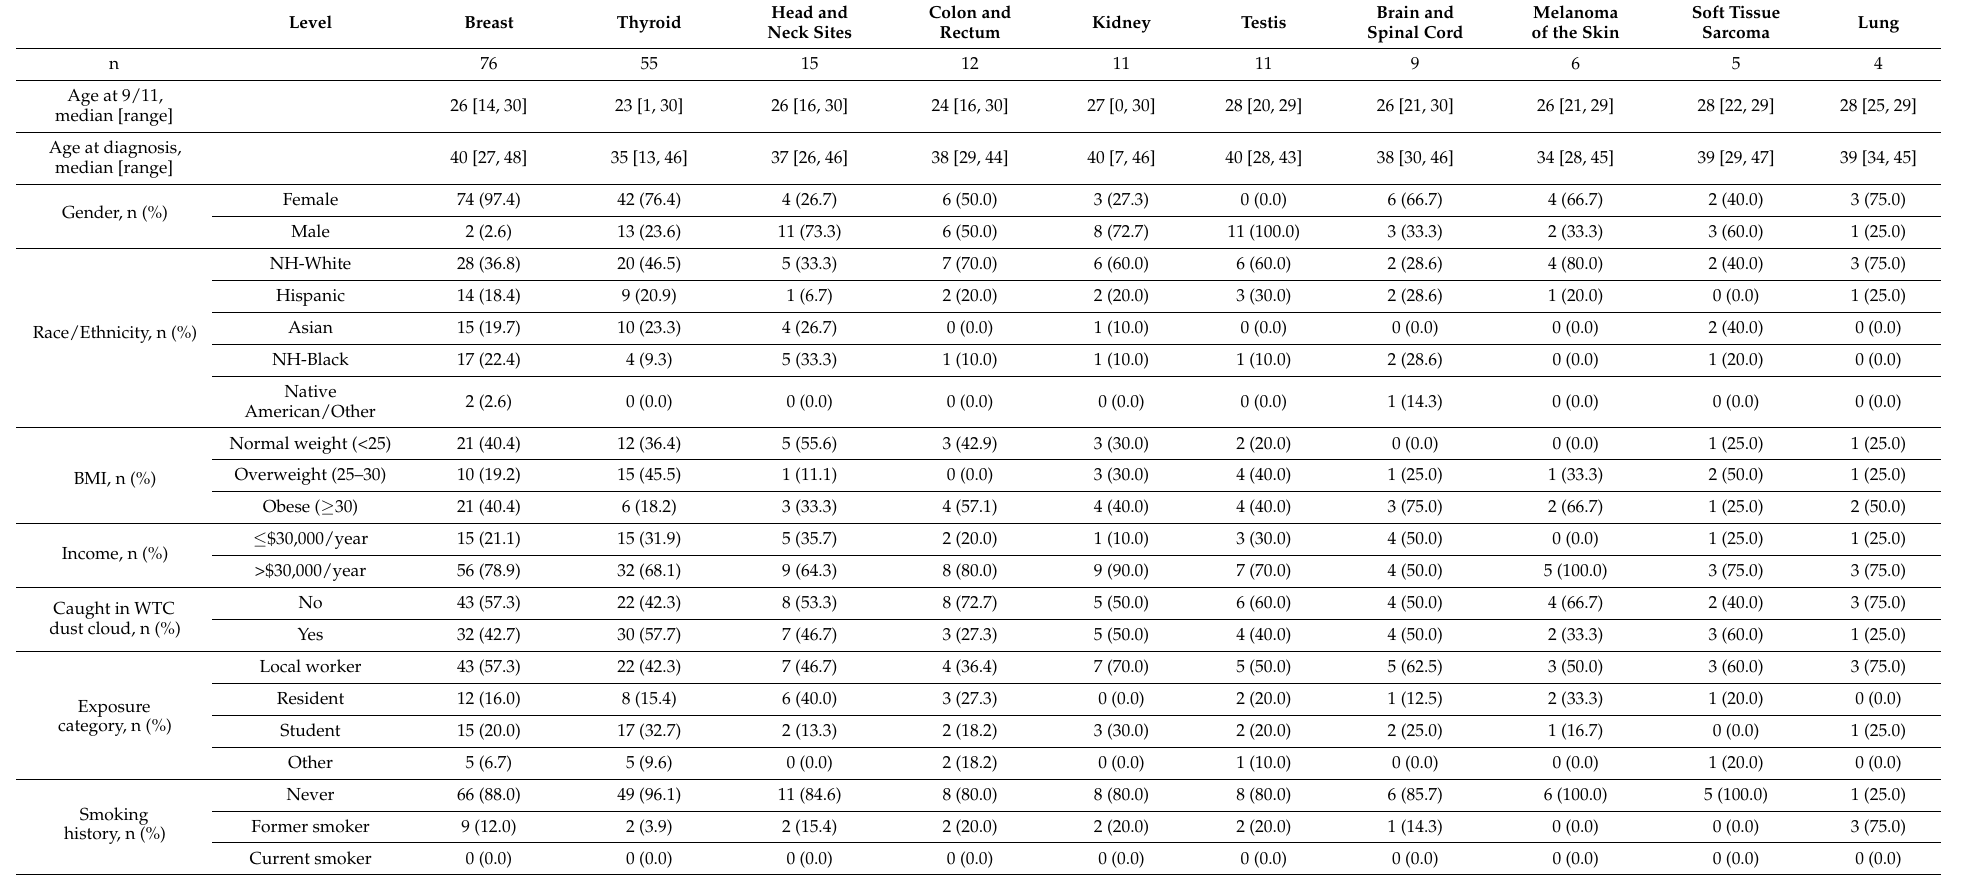
Table 2. Characteristics of EYA diagnosed with the 10 most common solid cancers included in the WTC EHC cancer analysis. Level Breast Thyroid Head and Neck Sites Colon and Rectum Kidney Testis Brain and Spinal Cord Melanoma of the Skin Soft Tissue Sarcoma Lung 11 6